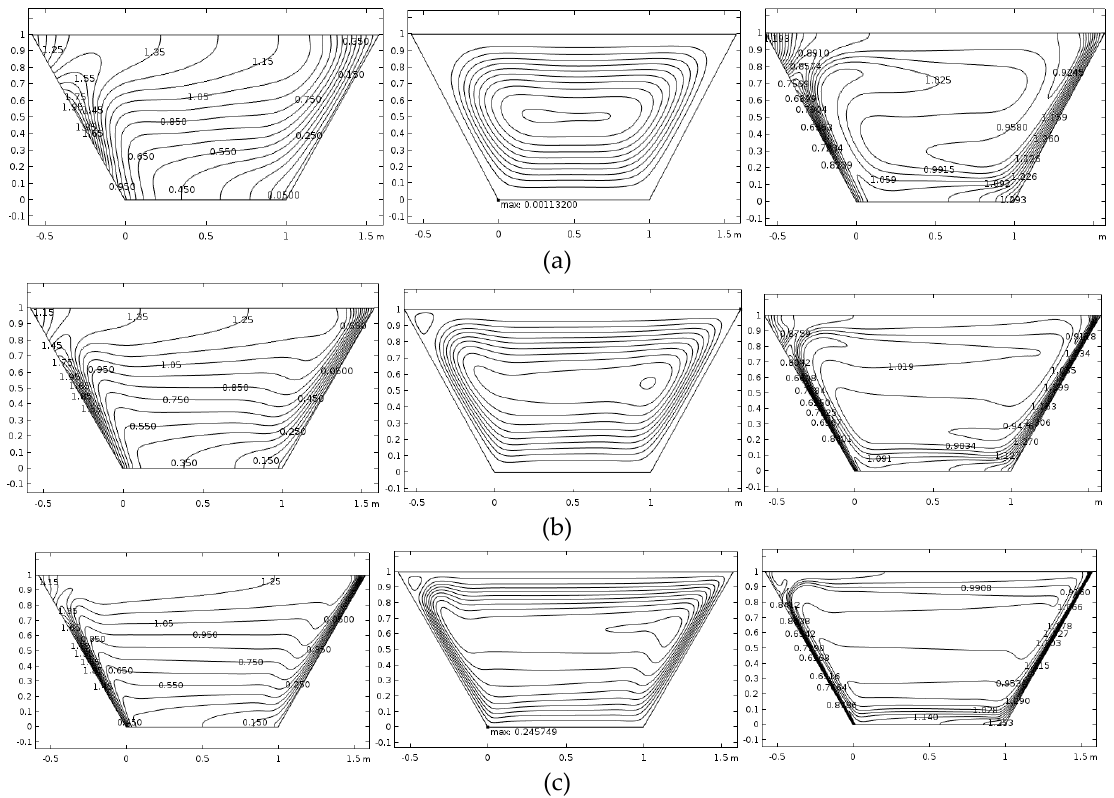
Figure 3. Isotherms, streamlines, and isoconcentrations for Pr = 7, ϕ = π / 6, κ = 1, ε = 0.5, and ( a ) Ra = 10 4 , ( b ) Ra = 10 5 , ( c ) Ra = 10 6 .